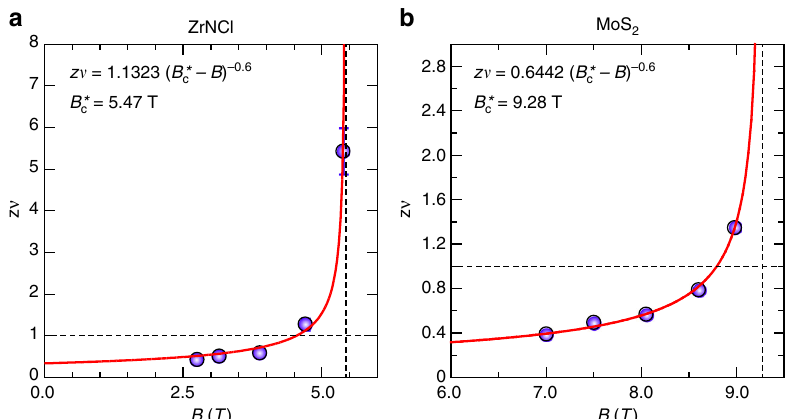
Fig. 3 Divergent behavior of critical exponent in ion-gated ZrNCl and MoS 2 . a , b Critical exponent z v as a function of magnetic fi eld B for ZrNCl- ( a ) and MoS 2 -EDLT ( b ). The z v values in each temperature regime is calculated by the fi nite-size scaling (FSS) analysis (see Supplementary Note 4). Error bars represent the width of z v value with which the FSS scaling behavior is established in the whole range of B for the data of Supplementary Figure 2. With increasing magnetic fi eld and decreasing temperature, the value of zv increases and fi nally shows divergent behavior with no signature of saturation. The (cid:5) (cid:6) (cid:2) 0 : 6 . Two black dashed lines in each graph represent the constant values with red curve shows a fi tting based on the activated scaling law, zv (cid:5) C B (cid:2) B (cid:6) c B (cid:6) ¼ 5 : 43 T and zv = 1 for a , and B (cid:6) ¼ 9 : 27 T and zv = 1 for b c c